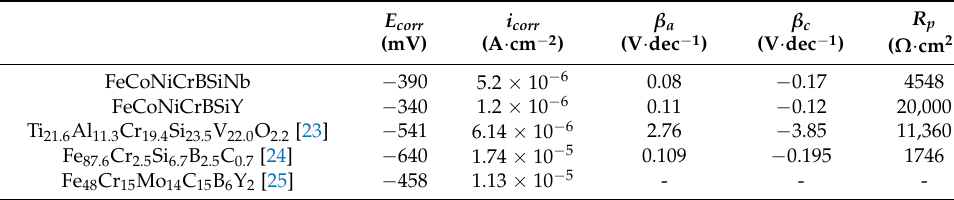
Figure 7. Potentiodynamic polarization curves of the laser cladding FeCoNiCrBSiY coating and FeCoNiCrBSiNb coating. Table 5. A series of electrochemical parameters fitted from the PDP